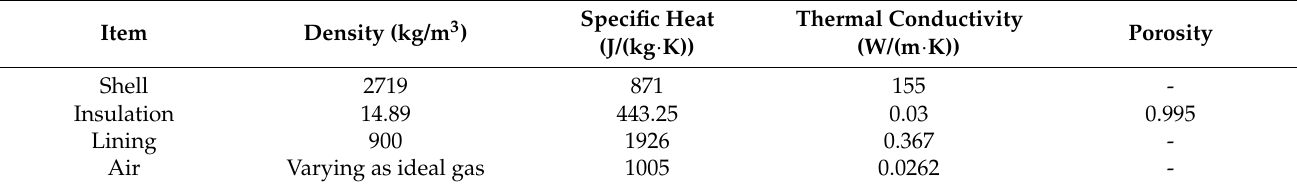
Table 3. Physical properties of aircraft